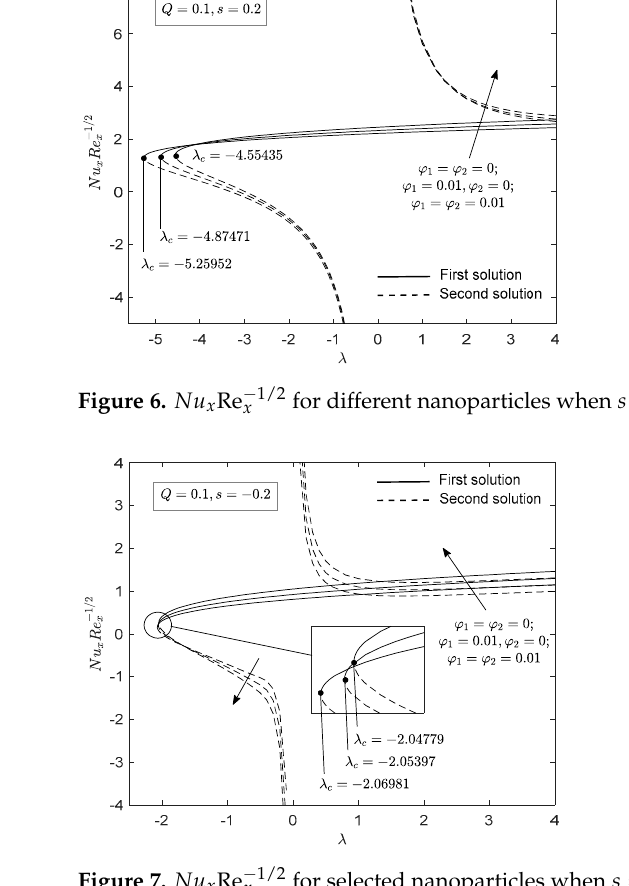
1 λ= − (op- 0.1 Q = − (heat absorption) to 0.1 Q = (heat generation) enhanced the momentum and (heat generation) enhanced the momentum and